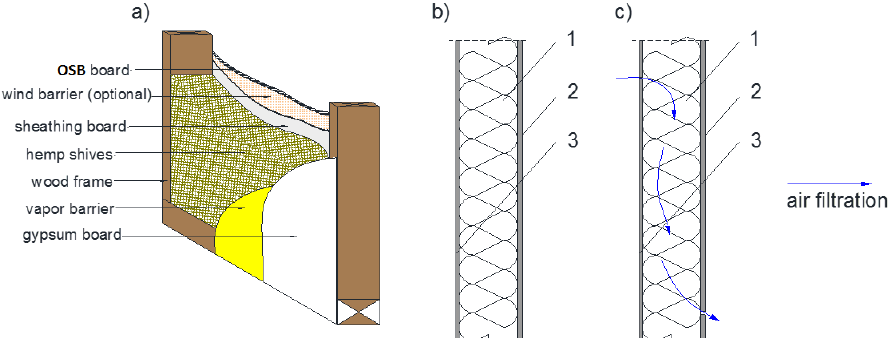
Figure 9. Cross-section of the simulation model, wall filled with hemp shives: ( a ) overall cross section, ( b ) no filtration case and ( c ) air infiltration case, 1—loose hemp shives (110 or 120 kg/m 3 ), 2—gypsum board and 3—OSB.